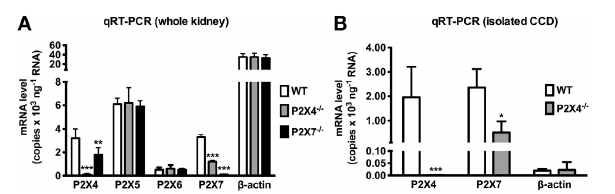
FIGURE 2 | (A) P2X4, P2X5, P2X6, P2X7 and β -actin mRNA levels in the whole kidney from wild-type (WT), P2X4 null (P2X4 − / − ) and P2X7 null (P2X7 − / − ) mice. P2X4, 5, 6 and 7 mRNA was readily detected in WT kidney. P2X4 and P2X7 mRNA levels were > 100-fold lower in P2X4 − / −